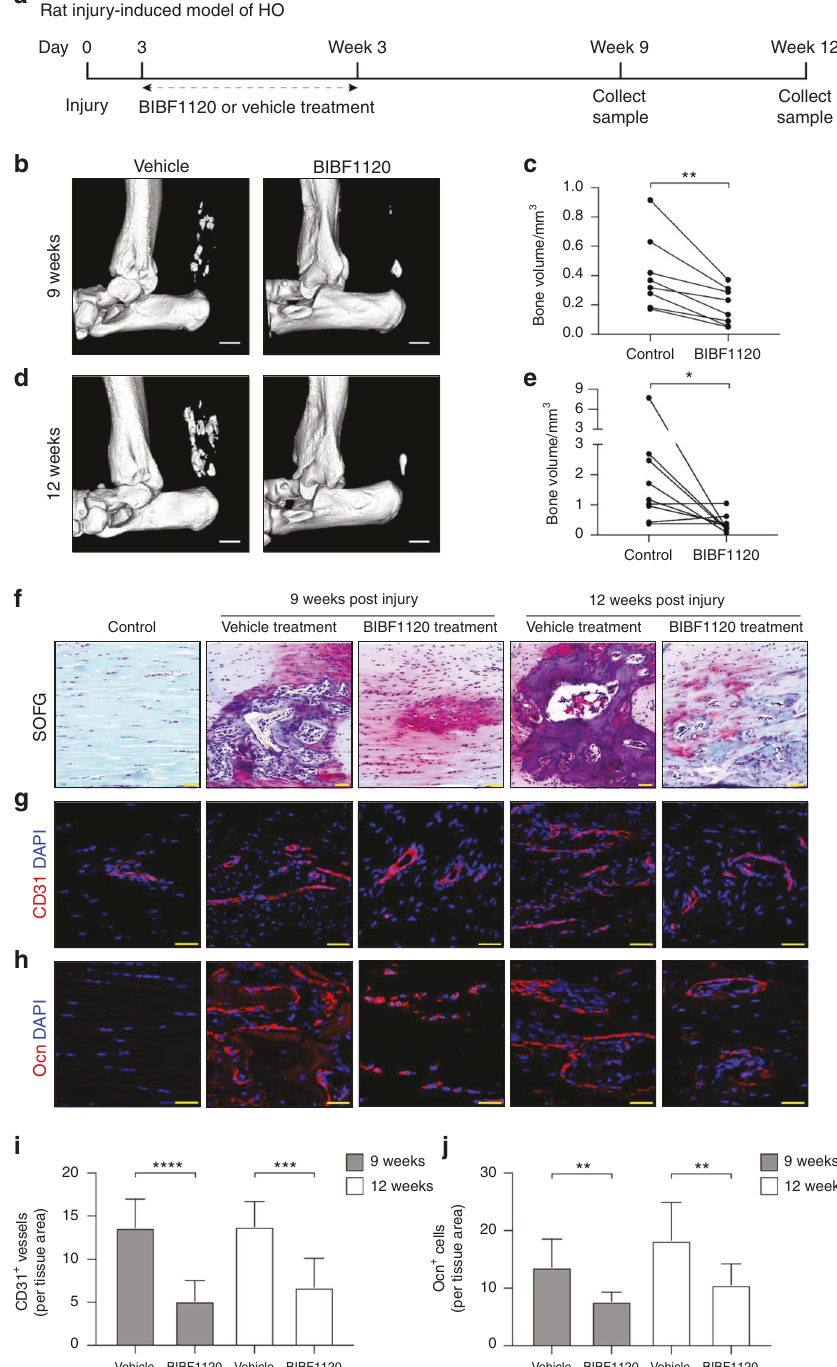
Fig. 7 The angiogenesis inhibitor BIBF1120 attenuates heterotopic bone formation in a trauma-induced model of rat HO. a Schematic illustration of the treatment and sample collection work fl ow for the rat HO model. b – e Micro-CT images of the Achilles tendons of rats in the BIBF1120 and vehicle treatment groups at 9 ( b ) and 12 weeks ( d ) post ATP. Scale bar, 1 mm. Quantitative analysis of the heterotopic bone volumes of the Achilles tendons at 9 ( c ) and 12 weeks ( e ) postinjury. f Safranin O-Fast green staining of the rat Achilles tendons of normal rats at 9 and 12 weeks postinjury. Scale bar, 50 μ m. g Immunostaining of CD31 + (red) vessels. Scale bar, 50 μ m. h Immunostaining of Ocn + (red) cells in ectopic bone marrow. Scale bar, 25 μ m. i , j Quanti fi cation of CD31 + ( i ) vessels and Ocn + ( j ) cells. All data are shown as the mean ± s.d. n = 8 per group. Statistic test: student t test. ** P < 0.01; *** P < 0.001; **** P < 0.000 BIBF1120 or vehicle (solvent used to dissolve BIBF1120, as a The angiogenesis inhibitor BIBF1120 attenuates the progression of negative control) was injected into the Achilles tendons of Mkx Mkx − / − and trauma-induced HO knockout mice three times a week for three consecutive weeks We next investigated whether the inhibition of angiogenesis from postnatal day 14. The mice were sacri fi ced at the age of 8 or would attenuate HO progression. The angiogenesis inhibitor